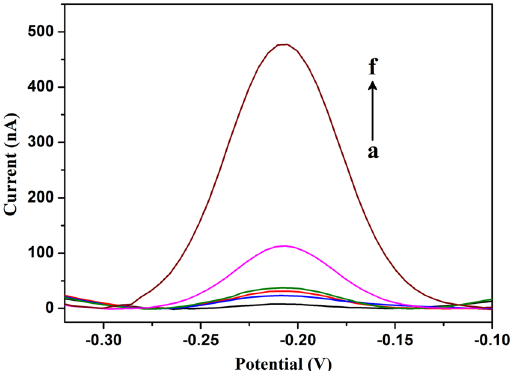
Figure 2. Differential pulse voltammograms (DPV) of the sensing system in the presence of: ( a ) melamine; ( b ) HP, MB-DNA, and melamine; ( c ) MB-DNA only; ( d ) MB-DNA and Exo III; ( e ) HP, MB-DNA, and Exo III; ( f ) HP, MB-DNA, melamine, and Exo